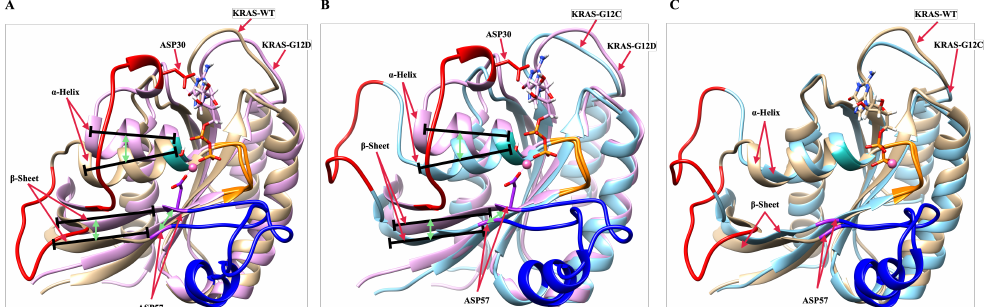
Figure 6. Alignment of three representative dominant structures of the GDP-bound KRAS-WT, KRAS-G12C and KRAS-G12D. ( A ) Alignment of GDP-bound KRAS-WT and GDP-bound KRAS- G12D; ( B ) alignment of GDP-bound KRAS-G12C and GDP-bound KRAS-G12D; ( C ) alignment of GDP-bound KRAS-WT and GDP-bound